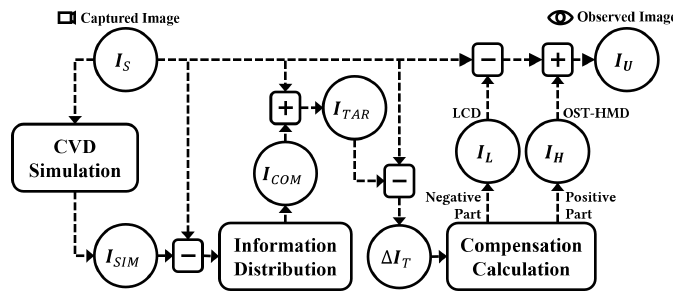
Figure 2. Daltonization process with an OST-HMD.